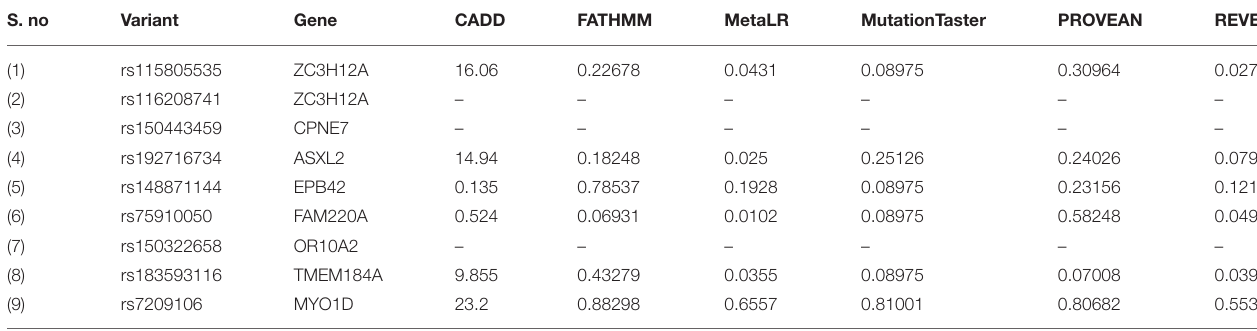
TABLE 2 | Computational pathogenicity prediction scores of the LD candidate